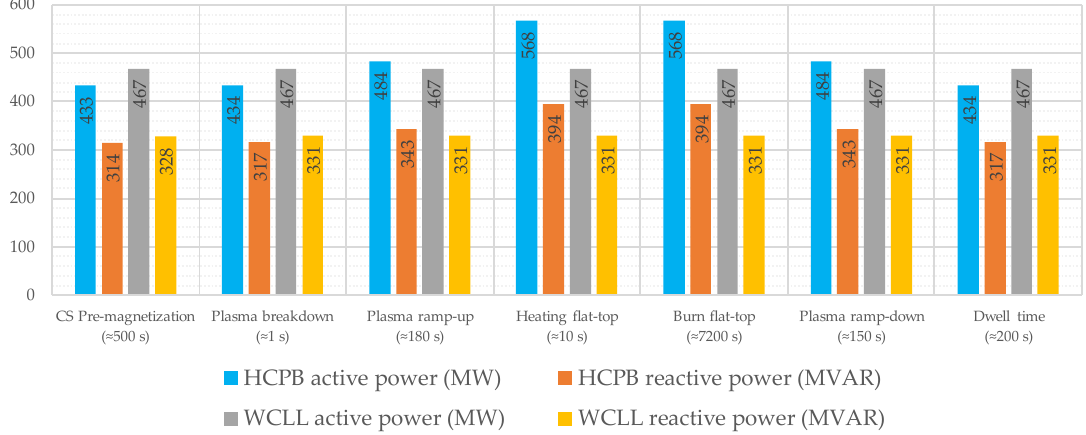
Figure 9. Total steady state electrical powers requested from the grid at the DEMO HV connection point in the two PHTS-PCS cases (HCPB and WCLL).